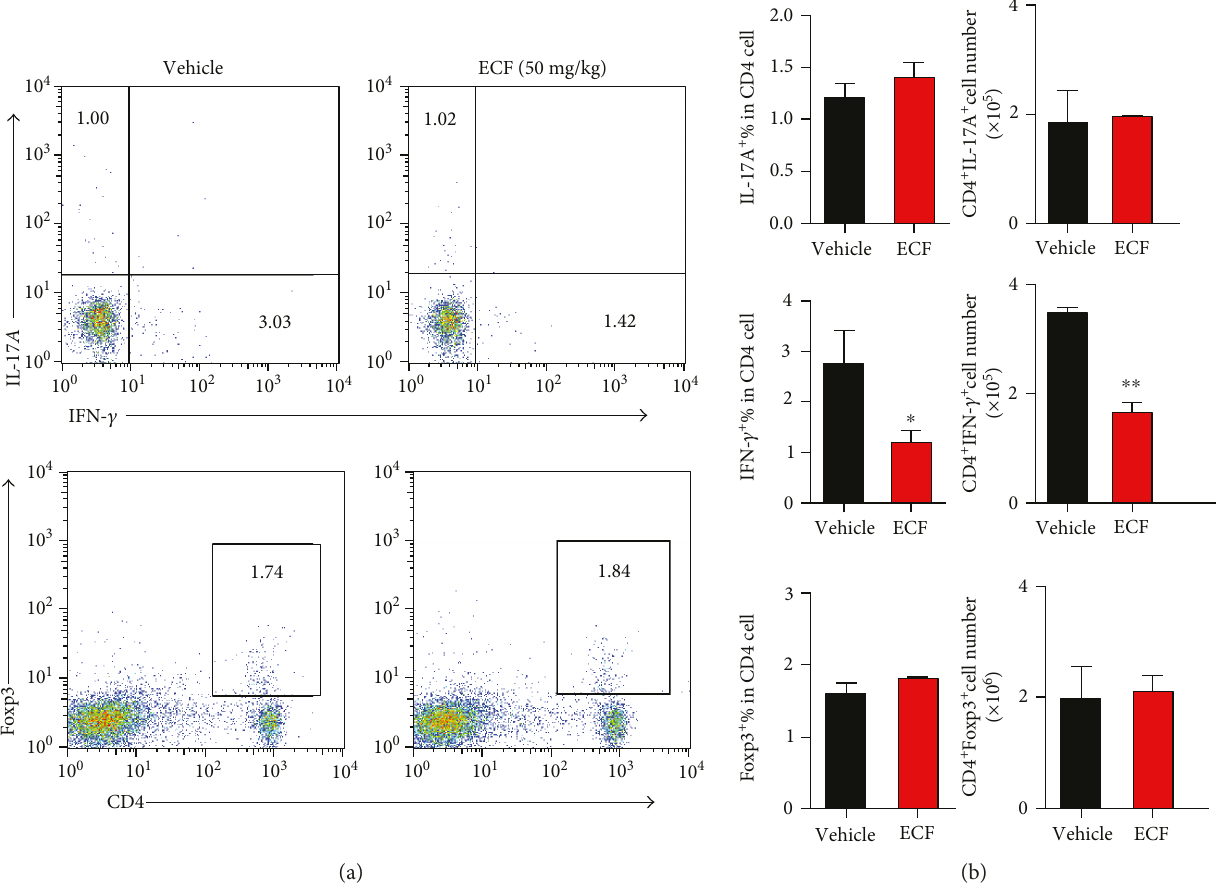
Figure 5: ECF treatment markedly suppresses Th1 cell response in CIA. Splenocytes from CIA mice were restimulated for 4 h with PMA and ionomycin in the presence of Brefeldin A. At the end of incubation, cells were collected and blocked with rat-anti-mouse CD16/CD32, and then those were stained with PE-Cy7-anti-mCD4 antibodies; cells were fi xed, permeabilized, and stained intracellularly with fl uorochrome- conjugated anti-mIL-17A, anti-mIFN- γ . Samples were acquired on fl ow cytometer and analyzed by FlowJo software. Results presented are mean ± s.e.m., n = 4 . ∗ P < 0 05 , ∗∗ P < 0 01 versus vehicle